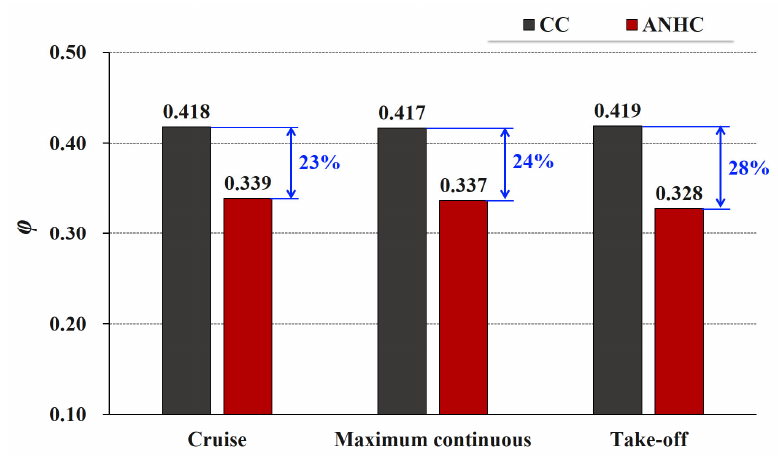
Figure 14. Flow coefficients of the rotor ‐ stator cavity under CC and ANHC.